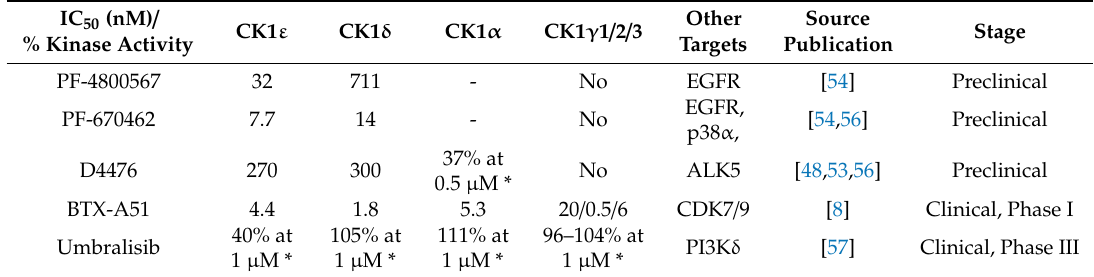
Table 1. Reported in vitro kinase assay IC 50 values and the most common o ff -targets of the CK1 kinase inhibitors used in the studies discussed in this